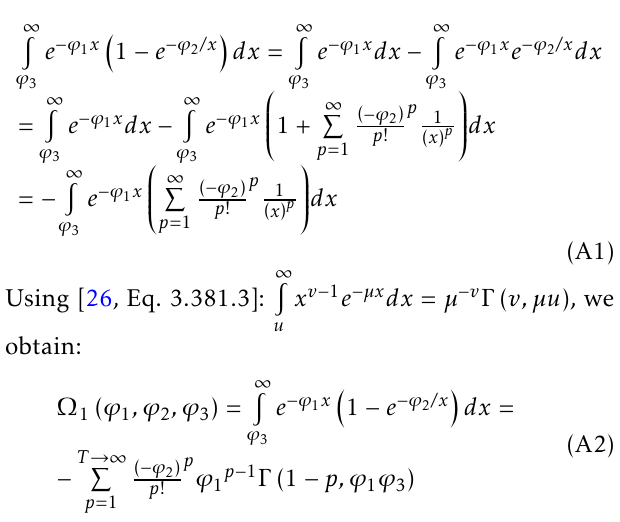
of 0.1, 0.4, and 0.7 with ( x R 1 R 2 , y R 2 ) =